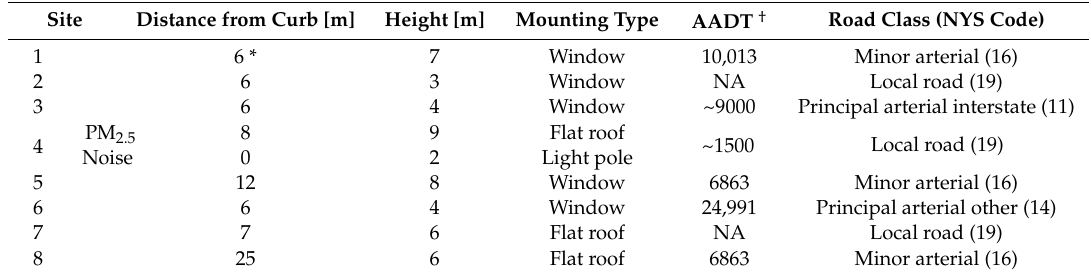
Table 1. Characteristics of PM 2.5 and noise monitoring